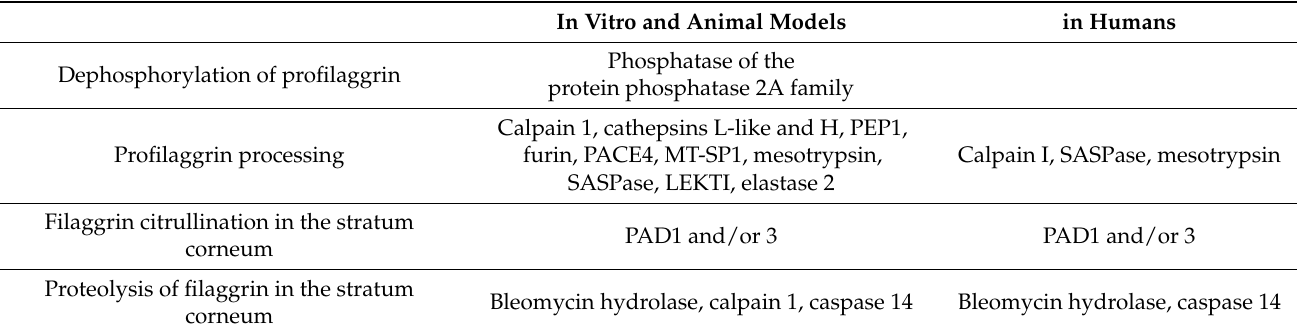
Table 1. Summary of enzymes and enzyme inhibitors involved in filaggrin metabolism (sometimes still hypothetic) in the epidermis according to data generated in vitro and in animal models versus in